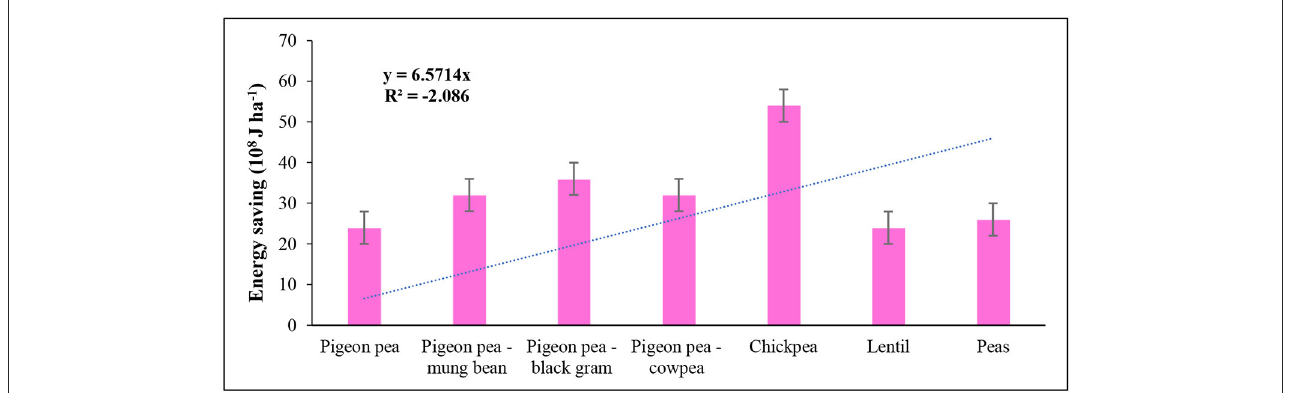
FIGURE8 Quantum of energy saved by pulse crops through N economy ( y = 6.5714x, R 2 = 0.7475 ). Sole cropping of chickpea saved maximum energy (54 × 10 8 J ha − 1 ) by saving 68kg N ha − 1 followed by pigeon pea–urd bean rotation (36 × 10 8 J ha − 1 ), while the lowest energy saving was observed from both lentil and pigeon pea (24 × 10 8 J ha − 1 each) having N economy of 30kg N ha − 1 ( Data source: Ahlawat and Srivastava, 1997; Kumar and Yadav,